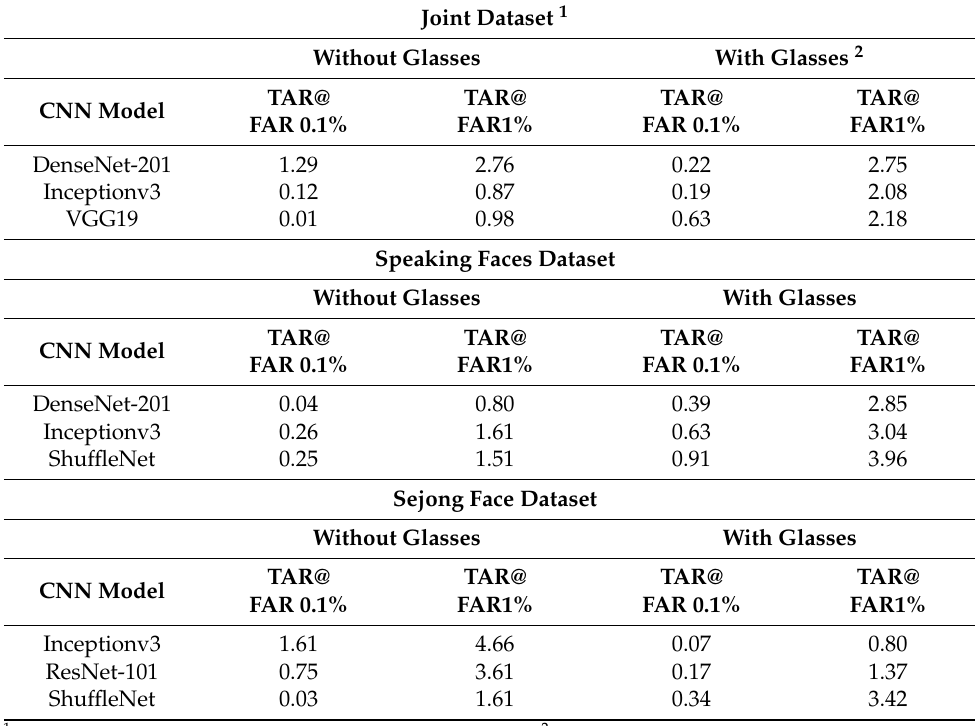
Table 6. Performance of VTI for the joint, Speaking Faces, and Sejong Face datasets. Joint Dataset